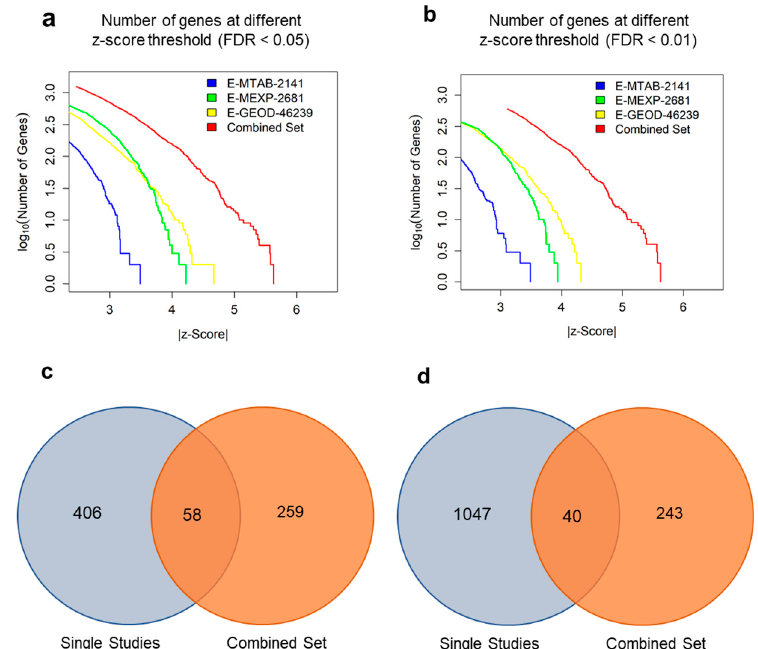
Figure 1. Identification of the DEGs by meta-analysis and comparison with the single study. ( a ) The number of DEGs in the log 10 scale and their z-scores at false discovery rate (FDR) < 0.05 and ( b ) FDR <